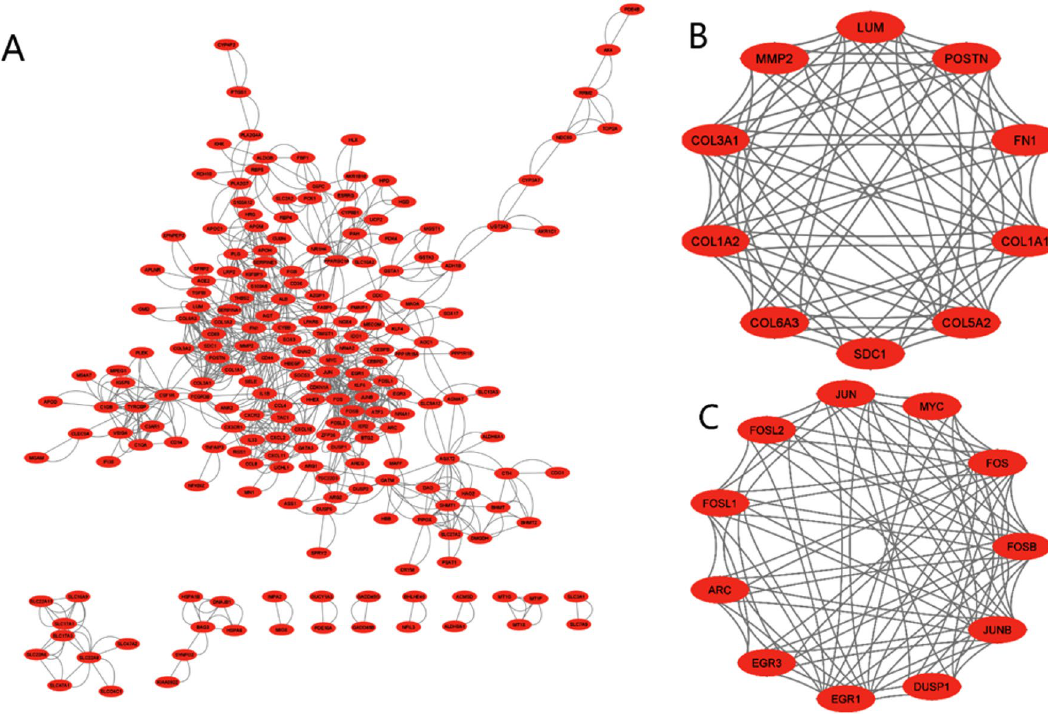
Figure 3. ( A ) PPI network of DEGs, ( B ) Module 1, and ( C ) Module 2. These three figures were generated by Cytoscape 3.9.1 54 (www. cytos cape. org).